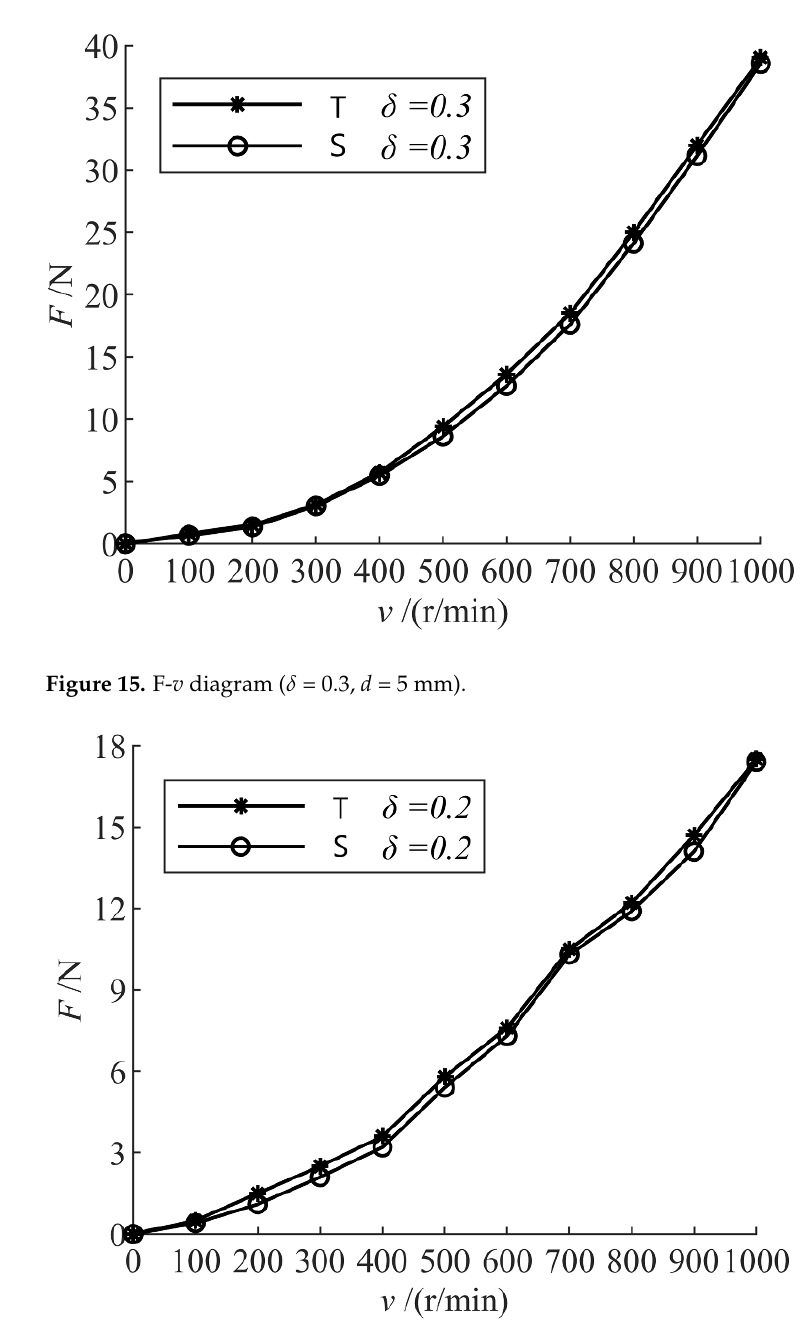
Figure 14. F- v diagram ( δ = 0.6 d = 5 mm).